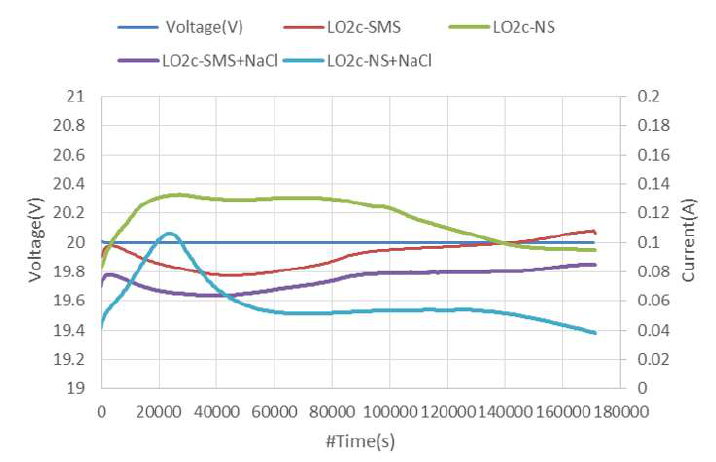
Figure 2. The course of the electrical current in the electrolyte during the preparation of the samples.